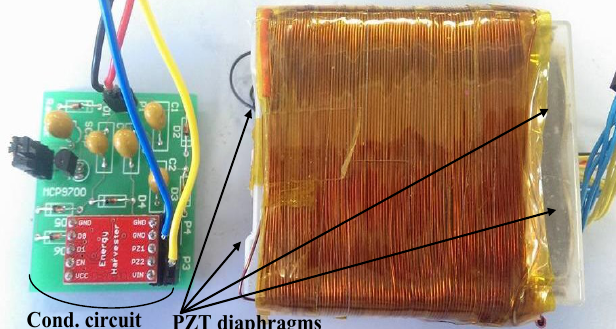
Figure 5: Prototype wearable piezoelectric-electromagnetic energy harvester.